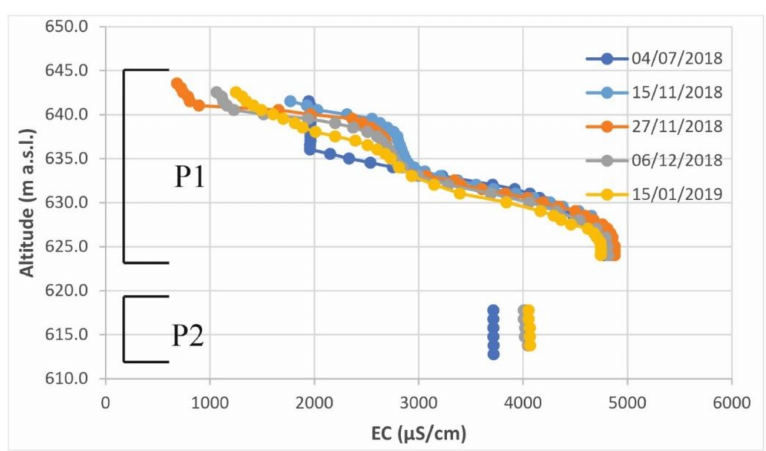
Figure 3. Vertical profile of groundwater Electrical Conductivity (EC) recorded in P1 and